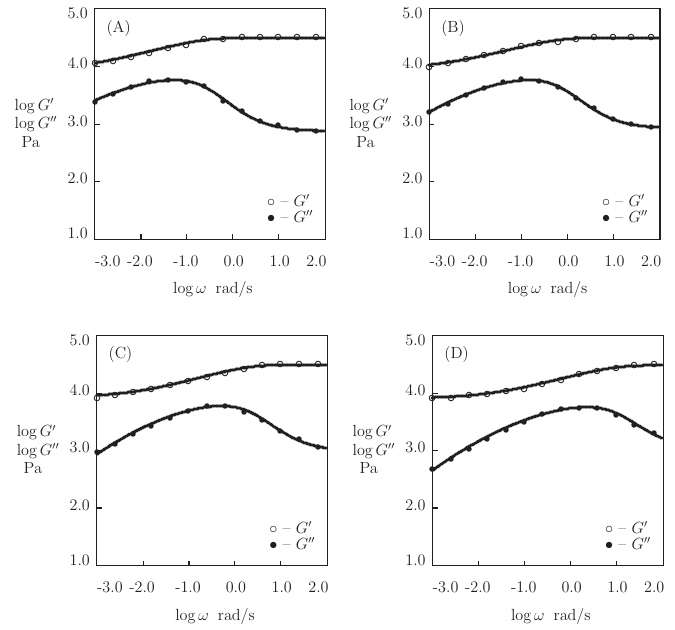
Figure 17. Storage modulus G (cid:48) and loss modulus G (cid:48)(cid:48) versus frequency ω . Symbols: experimental data [74] on o-Cys-P 4 -Cys gel (mass fraction of proteins 0.2) at various temperatures T (( A )– T = 15, ( B )– T = 25, ( C )– T = 35, ( D )– T = 45 ◦ C). Solid lines: the results of